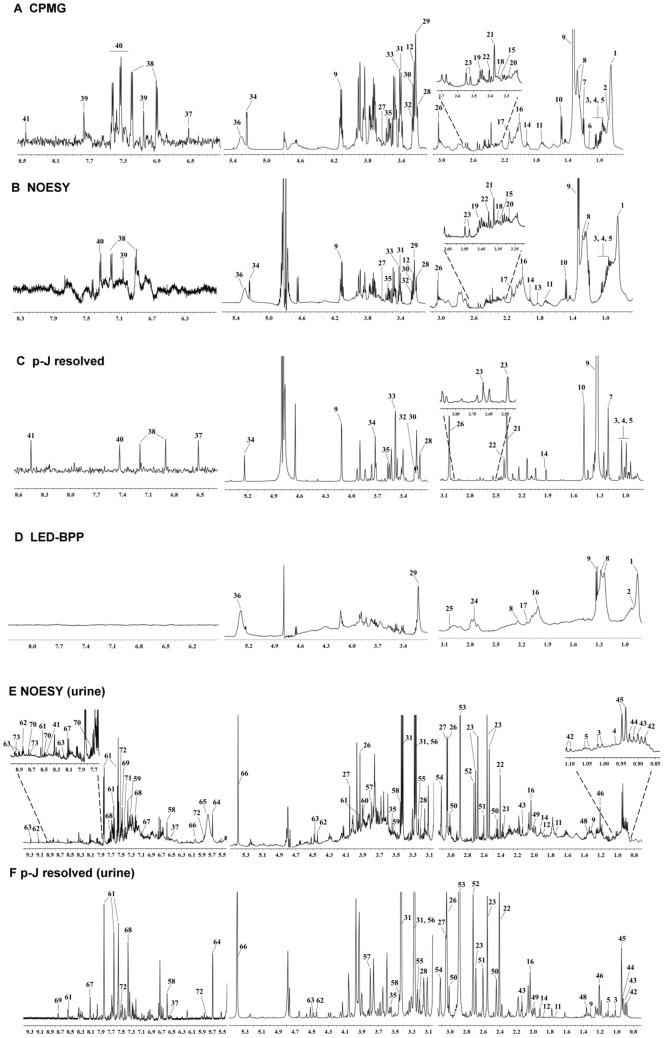
Typical 600 MHz 1H CPMG (A), NOESY (B), projected J-resolved (C),and BPP-LED (D) spectra of serum samples and 1H NOESY (E) and projected J-resolved (F) spectra of urine samples collected from the mice fed a normal chow diet at the 16 weeks.The keys metabolites in the serum and urine were assigned. The chemical shifts and peak multiplicity are described in Table S1 and Table S2.